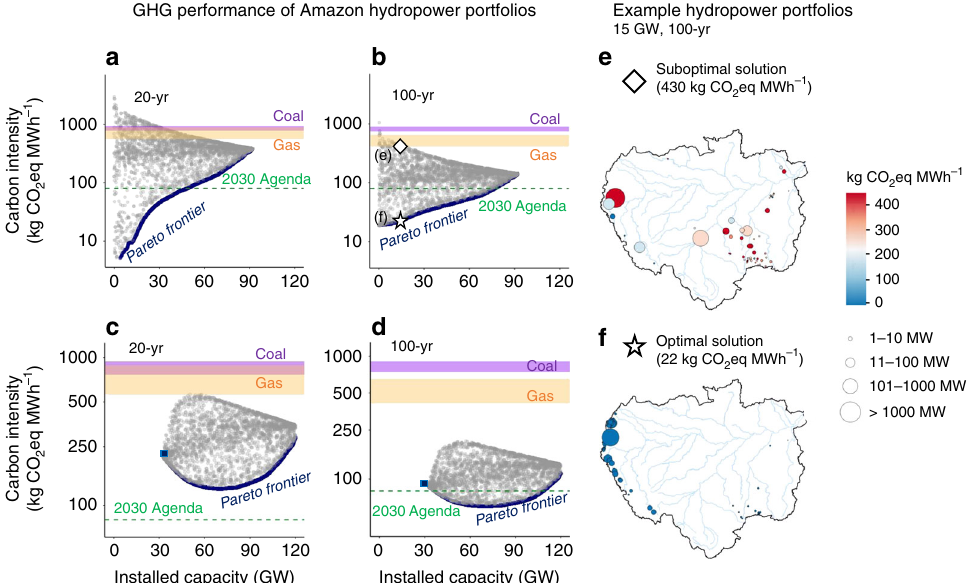
Fig. 2 Tradeoffs between hydropower generation and carbon intensity for portfolios of proposed Amazon dams. In a – d , each point represents a portfolio of dams. The optimal dam portfolios for each value of installed capacity (Pareto frontier) are shown in dark blue, and randomly generated suboptimal dam portfolios are shown by gray symbols. a and b show carbon intensity outcomes considering only the 351 proposed dams over 20-year and 100-year time horizons, whereas c and d show outcomes starting from the existing set of 158 Amazon dams (blue square; current installed capacity = 33 GW for an emission of 213 kg CO 2 eq MWh − 1 over a 20-year horizon and 87 kg CO 2 eq MWh − 1 over a 100-year horizon). The ranges of carbon intensities of coal- and natural gas- fi red power plants reported by the IPCC are shown in the purple and orange bands, respectively 7 . The carbon intensity of electricity produced from natural gas is closer to that of coal over shorter time frames due to its higher methane emissions. The green dashed line indicates the projected carbon intensity of the global electricity sector based on a scenario consistent with the UN 2030 Agenda for Sustainable Development 23 . A suboptimal and a Pareto-optimal dam portfolio, both with the same installed capacity (15 GW) but with contrasting carbon intensities (100-year time horizon), are illustrated in ( e ) and ( f